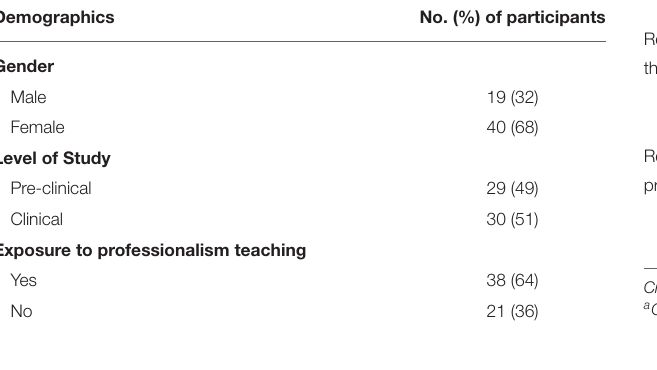
TABLE 2 | Demographic characteristics of our study participants ( n = 59).